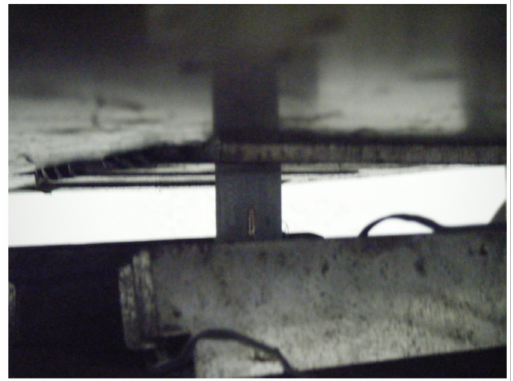
Figure 3. Tension test setup of pultruded FRP